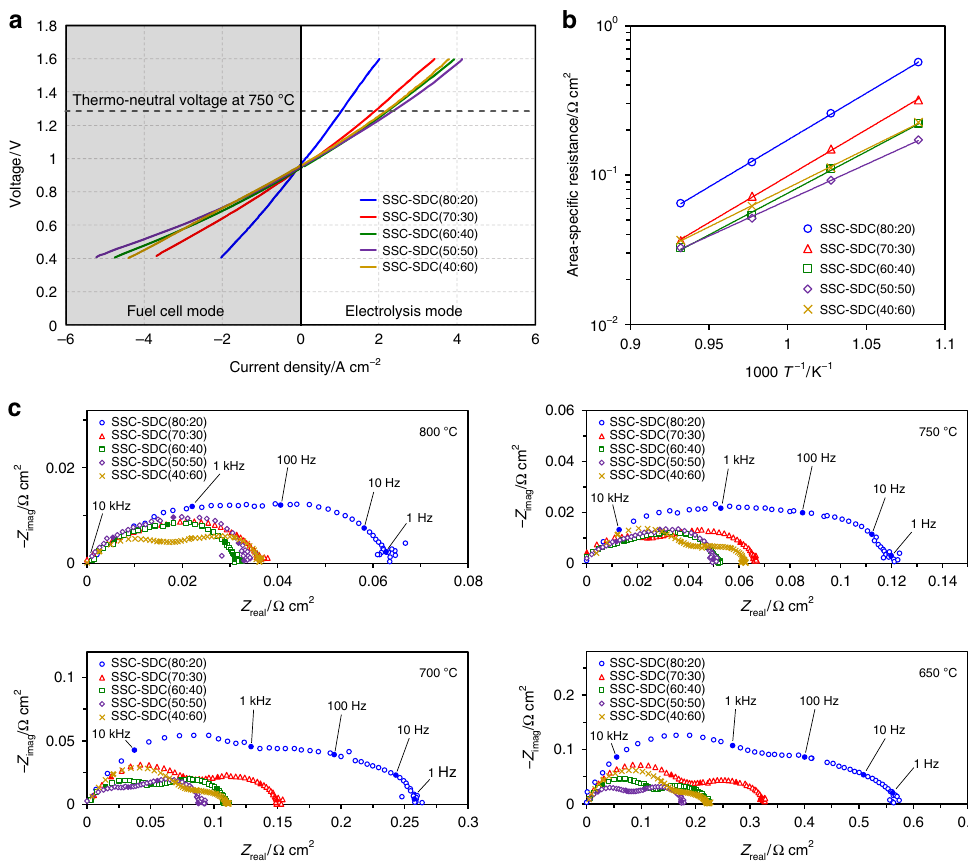
Fig. 4 Comparison in electrochemical performance of nanocomposite electrodes. SOECs with the SSC-SDC nanocomposite electrodes where SSC:SDC composition ratio was 80:20 – 40:60 were operated under 40% humidity condition. a I – V characteristics in both electrolysis and fuel cell modes at 750 °C. b ASRs of electrode polarization and c impedance spectra at 650 – 800 °C under OCV